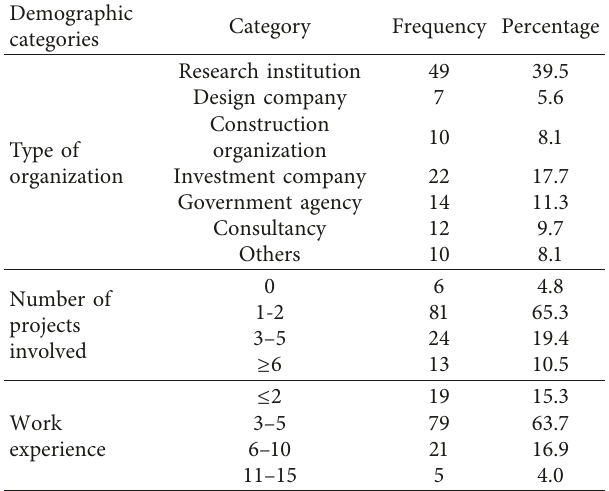
Table 2: The demographic information of the